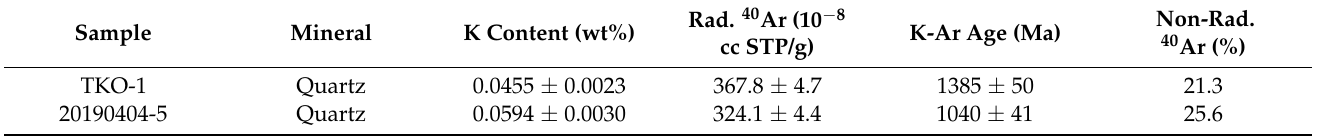
Table 2. K-Ar dating results for quartz samples from the Thongkai-Ok